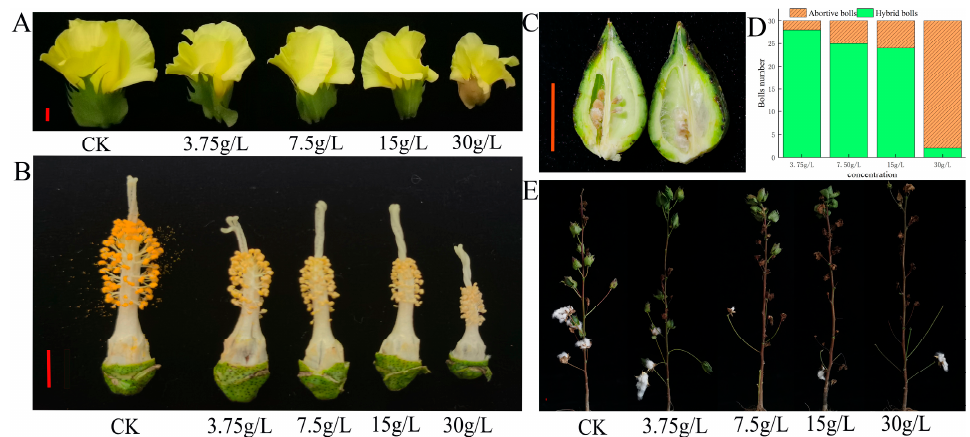
Figure 1. Fertility and yield-related phenotypes of Sea Island cotton after treatment with different concentrations of glyphosate. ( A ) Flower phenotypes of Sea Island cotton treated with different concentrations of glyphosate; ( B ) stigma and anther phenotypes of Sea Island cotton treated with different concentrations of glyphosate; ( C ) boll longitudinal and seed phenotypes of Sea Island cotton treated with different concentrations of glyphosate; ( D ) boll number of Sea Island cotton treated with different concentrations of glyphosate; ( E ) plant performance of Sea Island cotton treated with different concentrations of glyphosate. The scale bar is 1 cm.